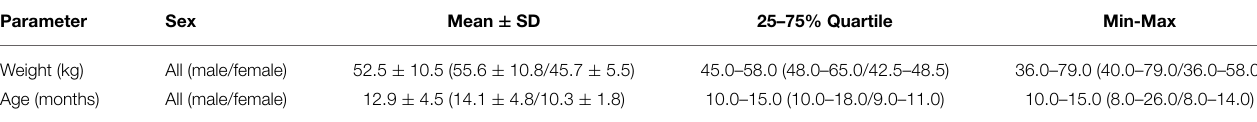
TABLE 3 | Demographic data within the proof-of-principle study ( n = 38